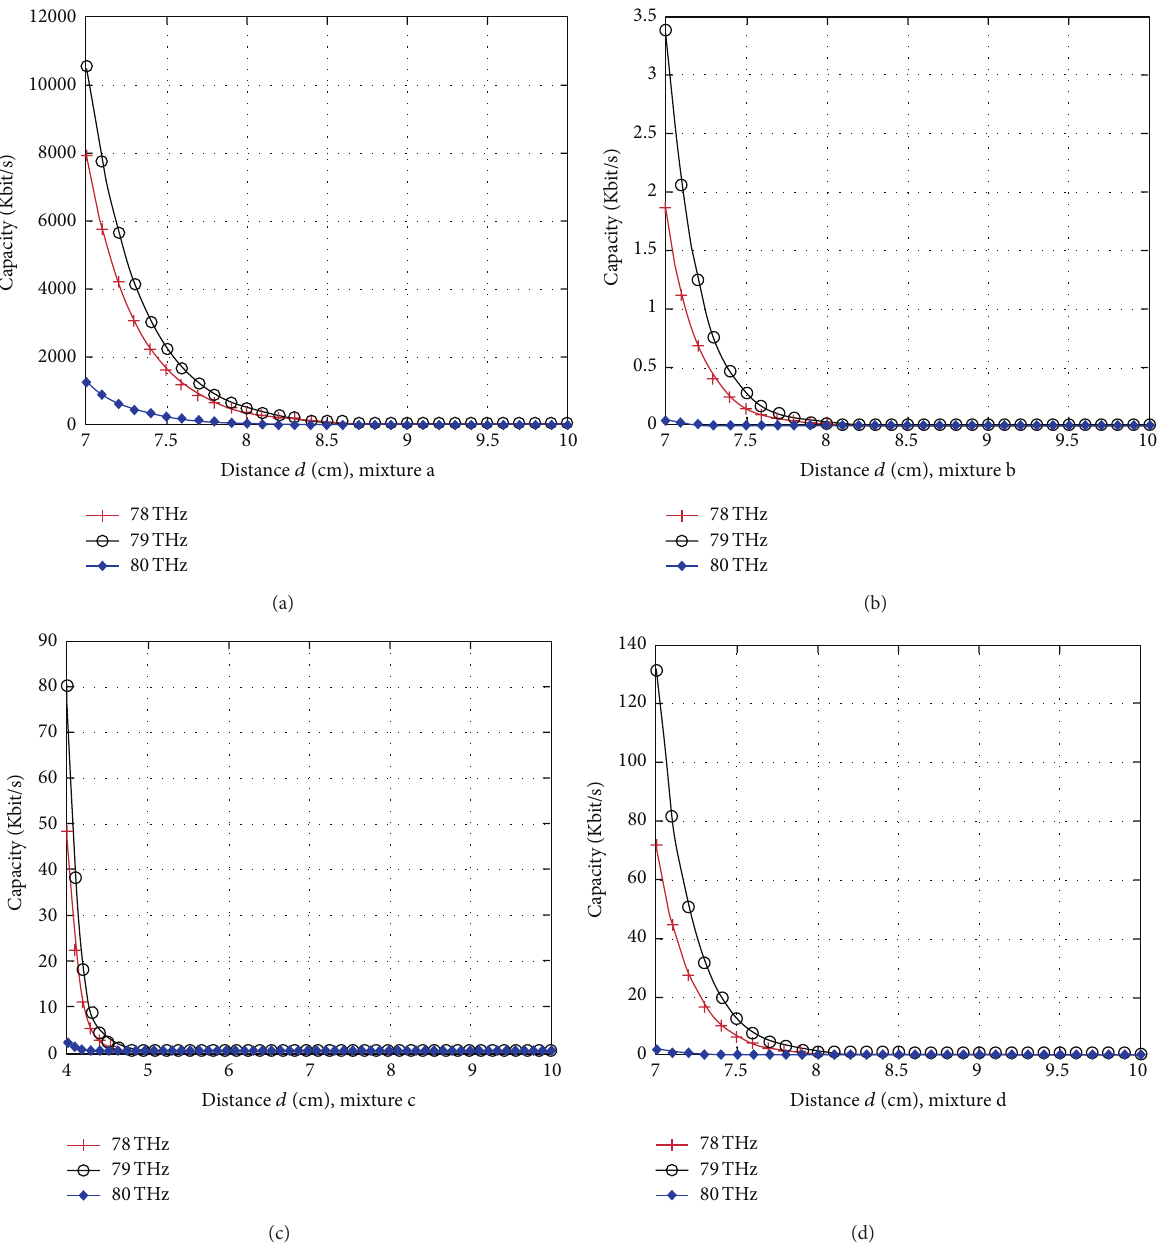
Figure 13: Capacity of the channel versus distance at 78 THz, 79THz, and 80 THz for mixtures (a), (b), (c), and (d) with 10dBm transmit